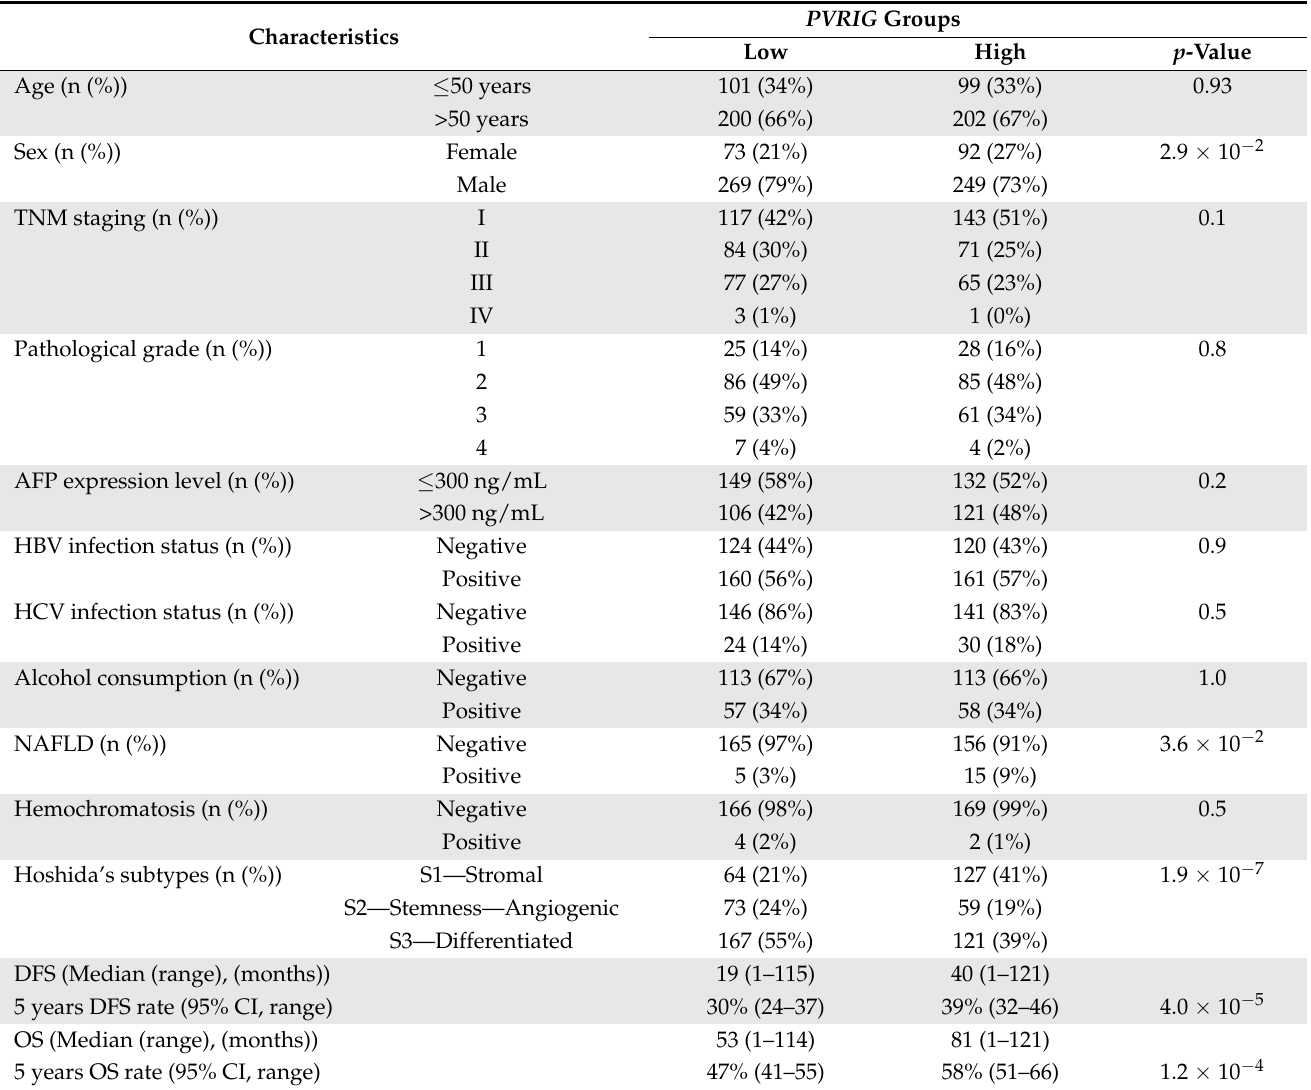
Table 2. Correlations of PVRIG gene expression with clinicopathological